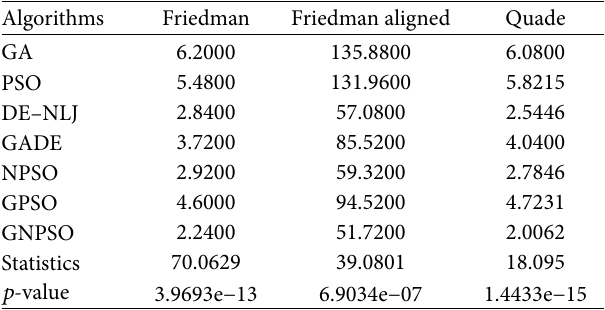
13: Ranks, statistics and related p -values achieved by the Friedman, Friedman aligned, and Quade tests for control perfor- mance of MIMO nonlinear wing vibration system obtained by dif- ferent algorithms.